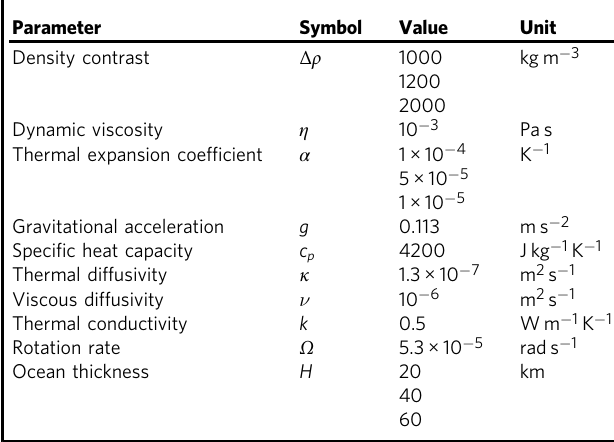
Table 1 Parameters for Enceladus ’ ocean used in our calculations 24,28,44,83